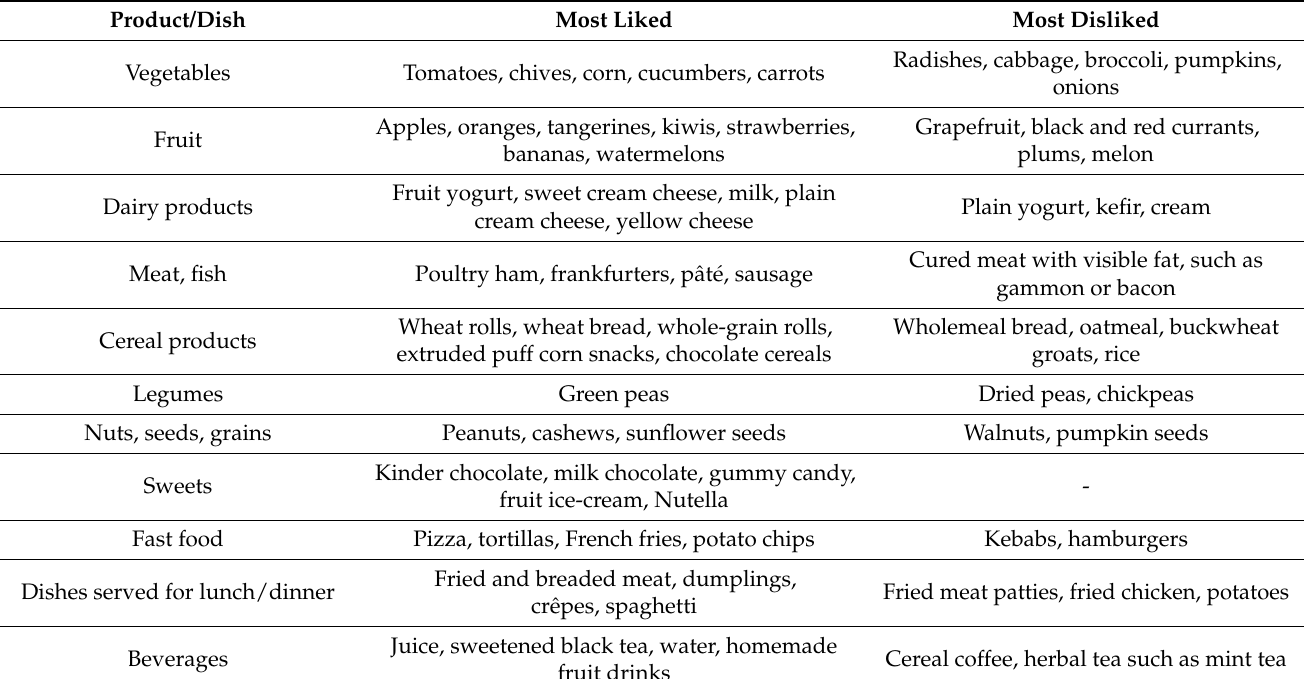
Table 1. Examples of products/dishes that were most liked and disliked by the respondents.